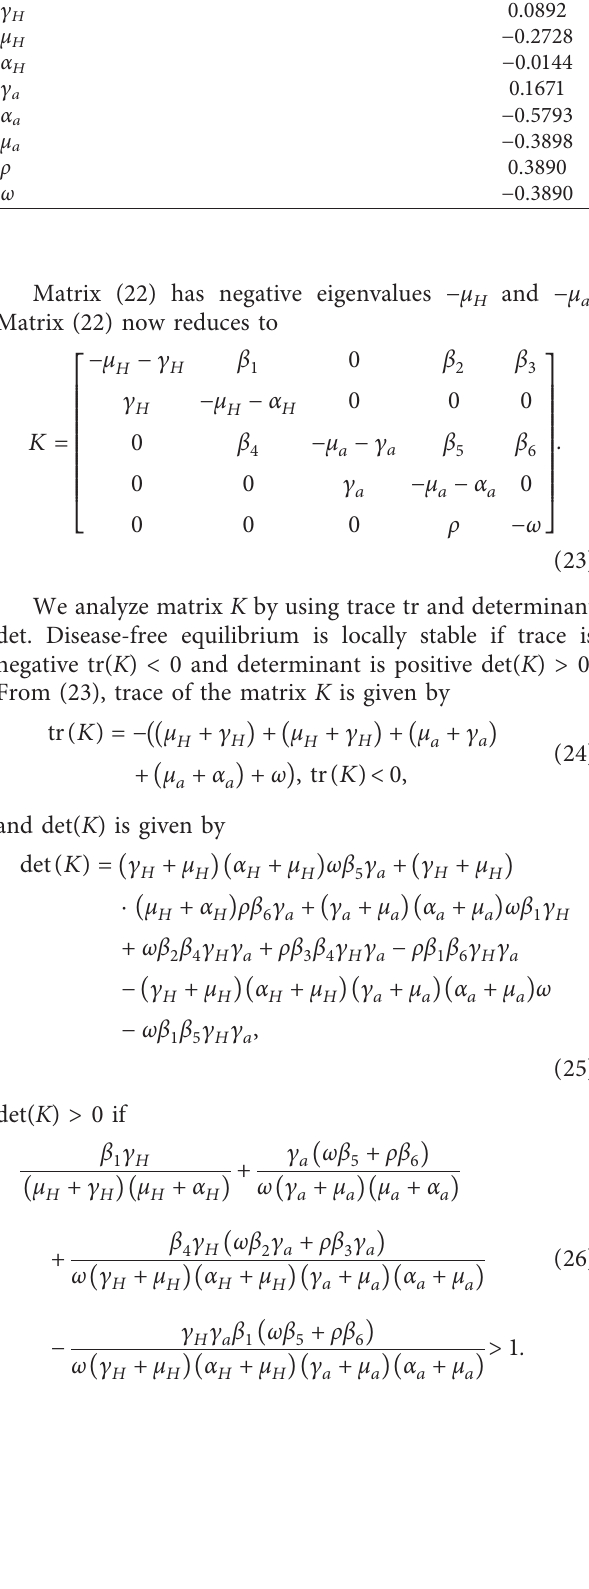
Table 3: Sensitivity indices for R